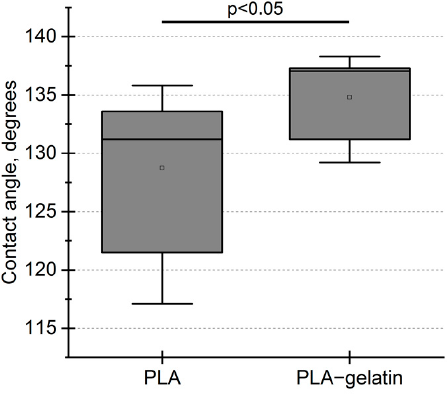
Figure 3. Initial contact angle of electrospun PLA and PLA–gelatin (9:1) mats. No water absorption was observed during the experiment (40 s). According to the Mann–Whitney U-test, the difference is statistically significant ( p < 0.05).